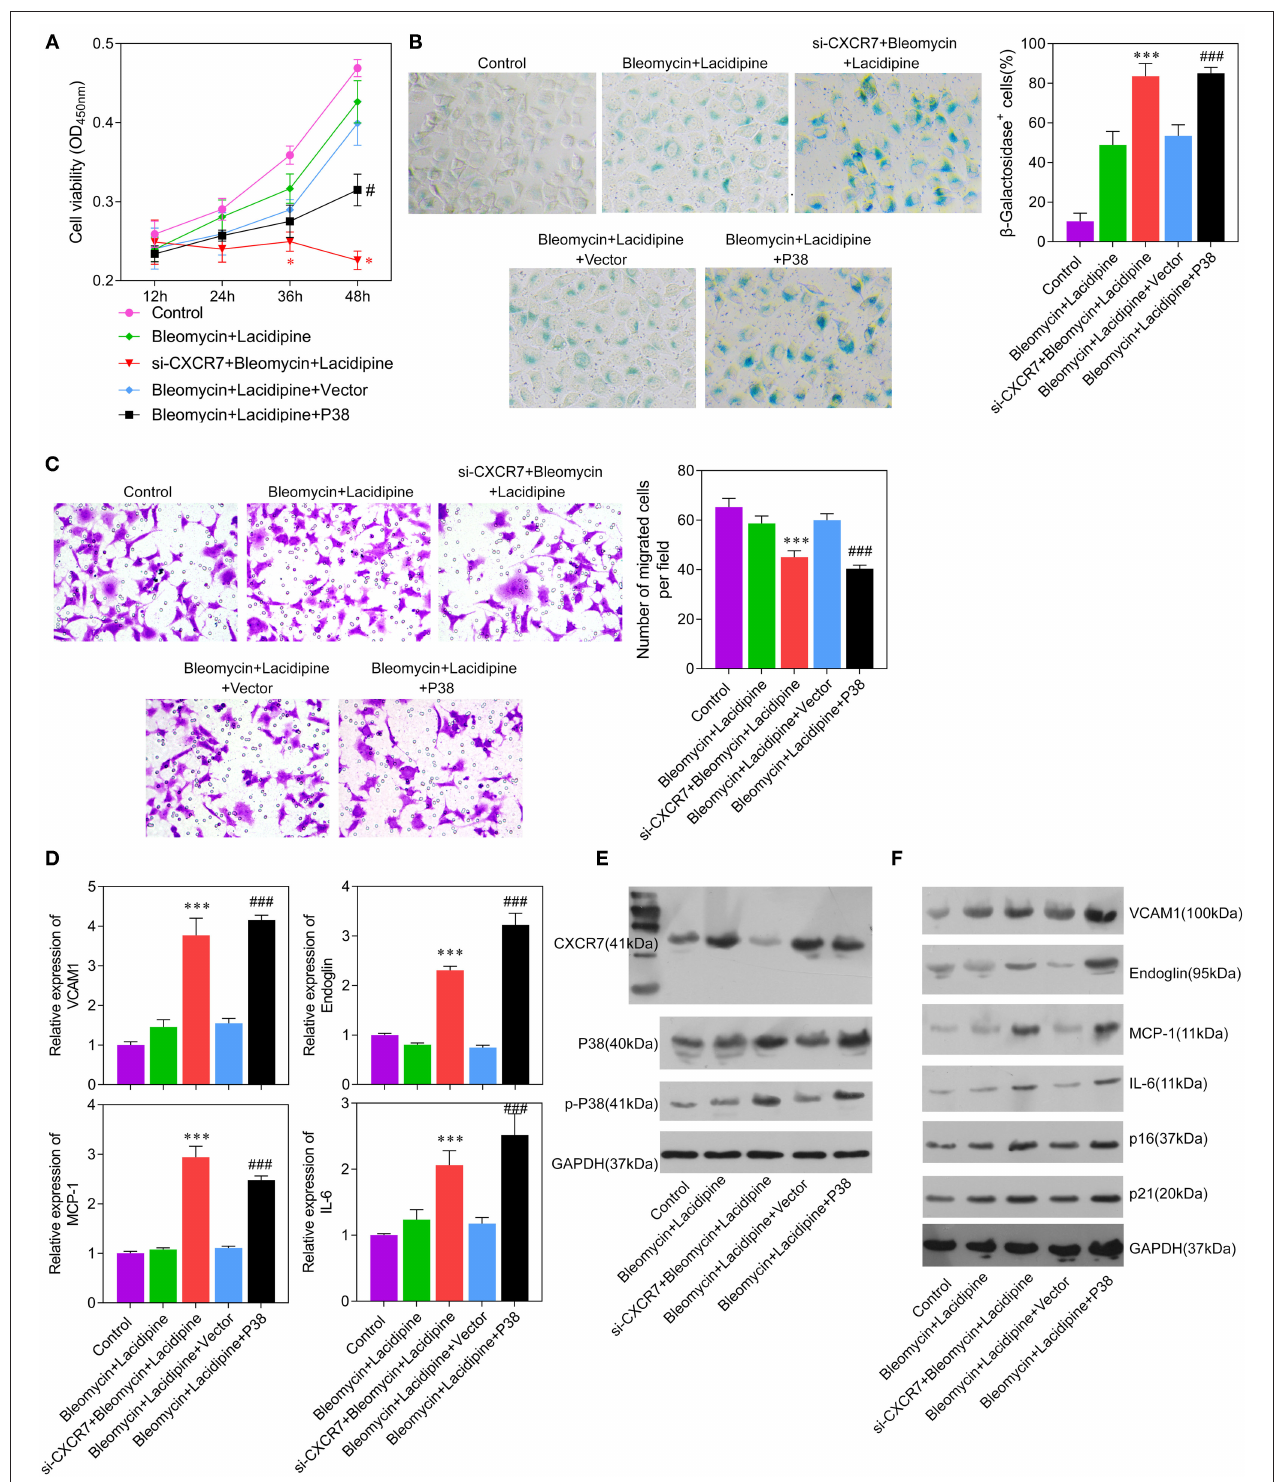
FIGURE 4 | CXCR7 knockdown reversed the effects of Lacidipine on the in vitro function of ECs under senescence. ECs from the bleomycin + Lacidipine group were transfected with si-CXCR7 or overexpressed P38, respectively. Cell viability was determined using CCK-8 assay (A) . Cell senescence was determined through β -galactosidase staining (B) . Transwell assay was applied to analyze cell migration ability (C) . qPCR was performed to analyze the mRNA levels of VCAM1, Endoglin, MCP-1, and IL-6 (D) . Western blot was performed to analyze the protein levels of CXCR7, P38, p-P38, VCAM1, Endoglin, MCP-1, IL-6, P16, and P21 (E,F) . (Data are mean ± SD of three independent experiments. * p < 0.05, *** p < 0.001, compared with the bleomycin + Lacidipine group; # p < 0.05, ### p < 0.001, compared with the bleomycin + Lacidipine + Vector group).